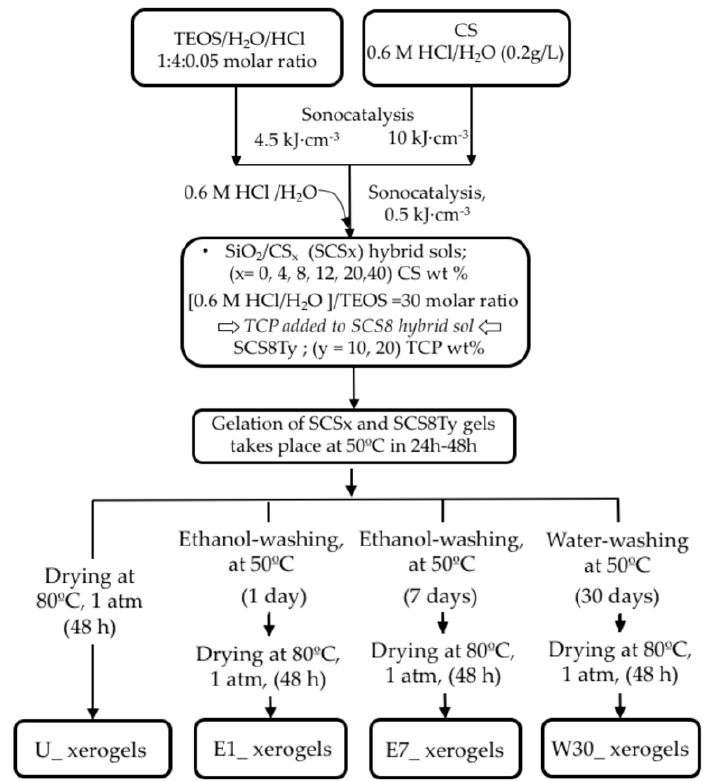
Figure 12. Scheme of the synthesis procedure for SiO 2 /CS/TCP xerogels following different washing treatments before evaporative drying.